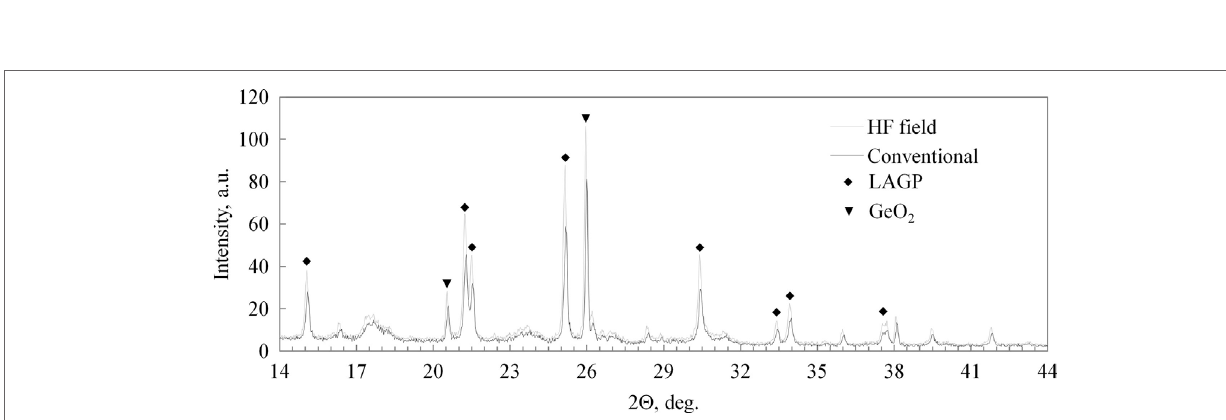
FigUre 5 | XrD of as-crystallized powders .